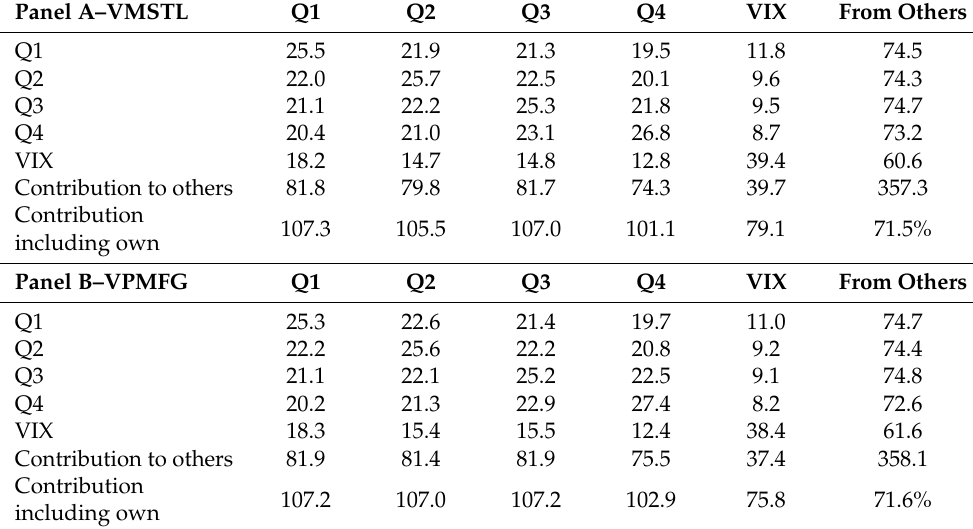
Table 5. Mutual spillovers